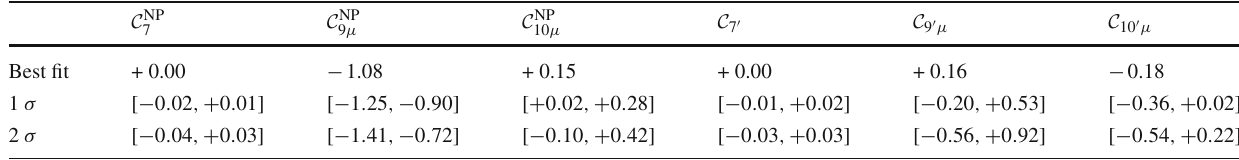
Table 3 1 and 2 σ confidence intervals for the NP contributions to Wilson coefficients in the 6D hypothesis allowing for NP in b → s μμ operators dominant in the SM and their chirally-flipped counterparts, for the fit “All”. The Pull SM is 6 . 3 σ and the p -value is 27 . 8%